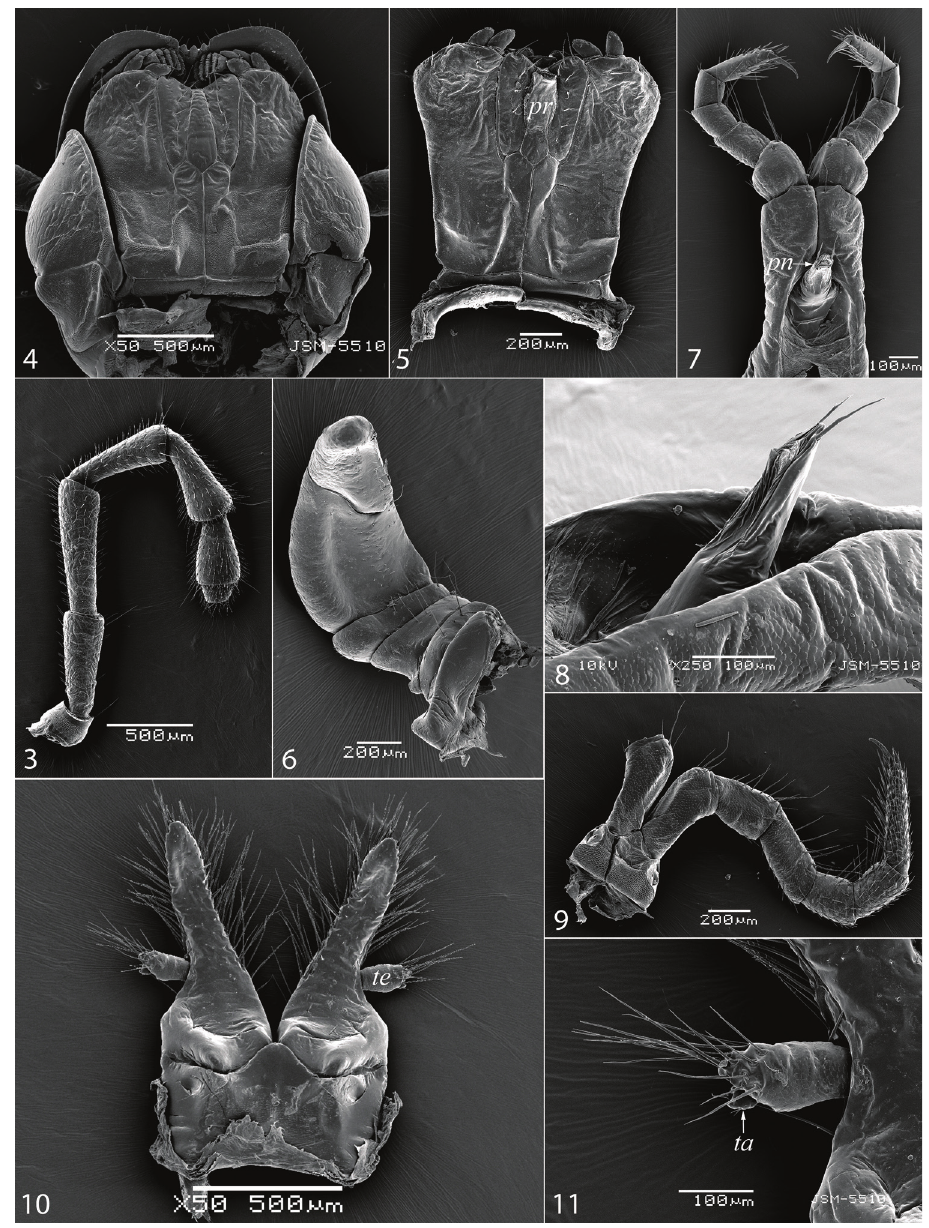
Figures 3–11. Skleroprotopus membranipedalis , external morphology: 3 male antenna 4 female head, ventral view 5 male gnathochilarium, ventral view 6 left male leg 1, latero-dorsal view 7 male leg-pair 2 with penis, caudal view 8 penis in situ , lateral view 9 left male leg 3, caudal view 10 male leg-pair 7, caudal view 11 telopodite of male leg 7, caudal view. Symbols: pn : penis, ta : tarsal remnant with apical claw, te :